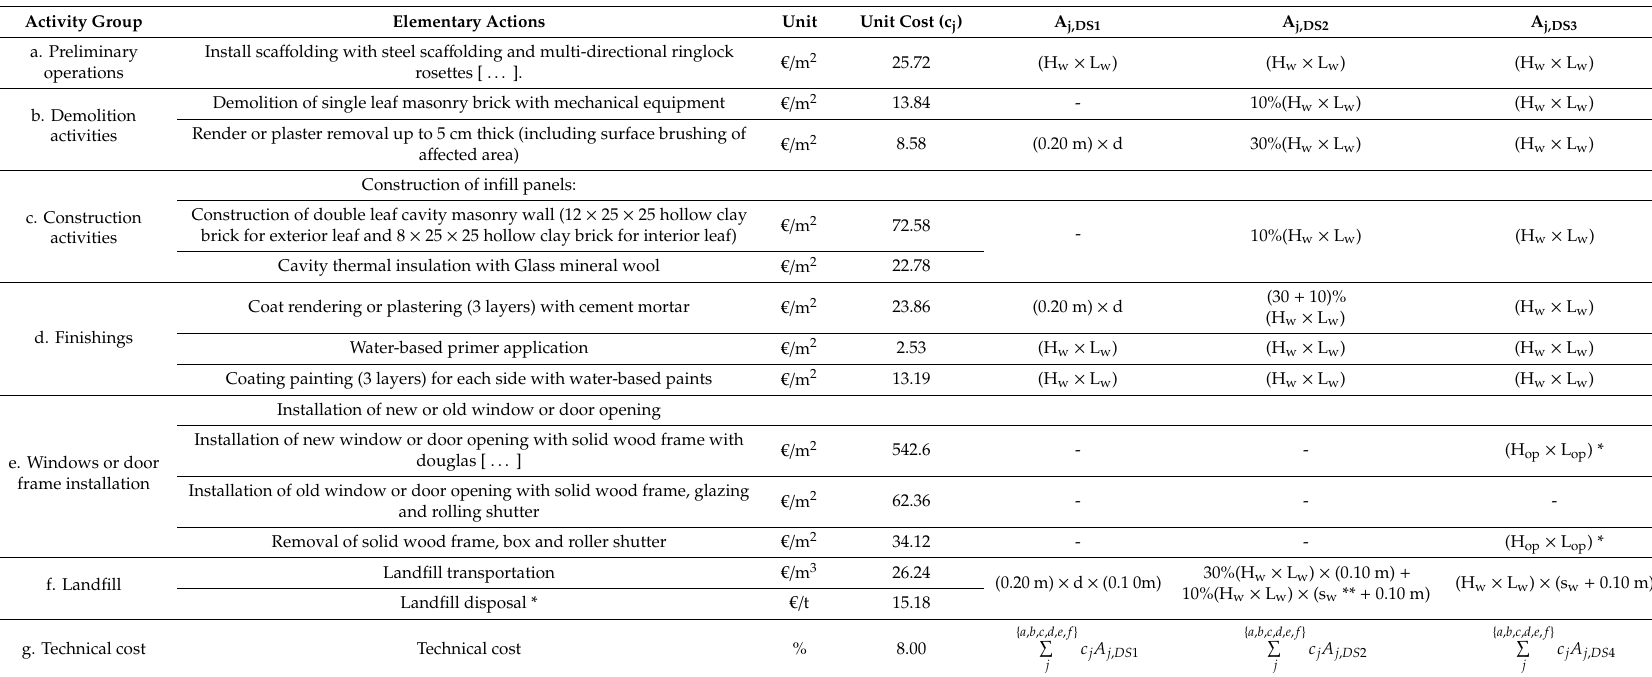
Table 2. Extension of intervention for each elementary actions and related unit cost according to [23]—adapted from